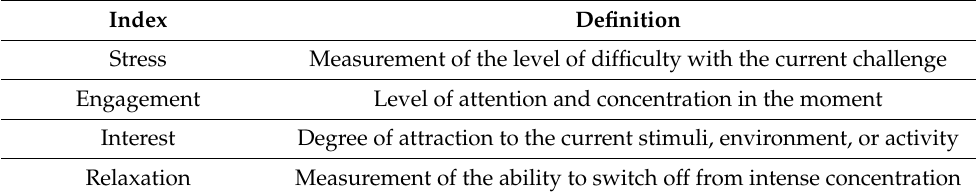
Table 3. Definitions of psychophysiological indices.